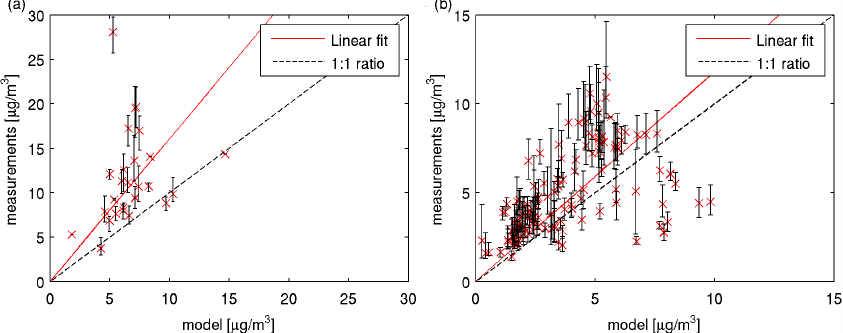
Fig. 5. Scatter plot of the observed annual mean PM 2 . 5 concentrations at various sites and the simulated five-year mean surface PM 2 . 5 in model grid boxes corresponding to these sites. The measurement data have been taken from (a) EMEP and (b) IMPROVE. The error bars represent the year-to-year variation and the red dots the five-year mean value of the observations. The dashed lines indicate the 1 : 1 ratio between the simulated values and observations, and the red lines indicate a linear fit to the